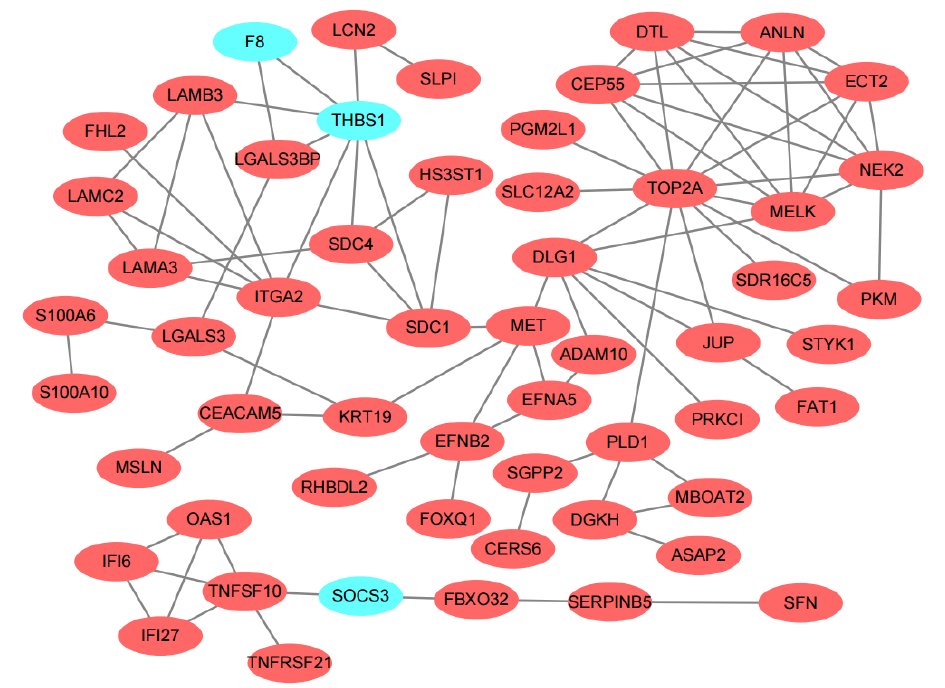
Figure 3. Differentially expressed genes protein–protein interaction (PPI) network was constructed and visualized using Cytoscape software. Red nodes represent up-regulated genes and baby blue nodes represent down-regulated genes in pancreatic adenocarcinoma compared to the normal samples. Only two nodes included one edge and alone node were removed from the network.